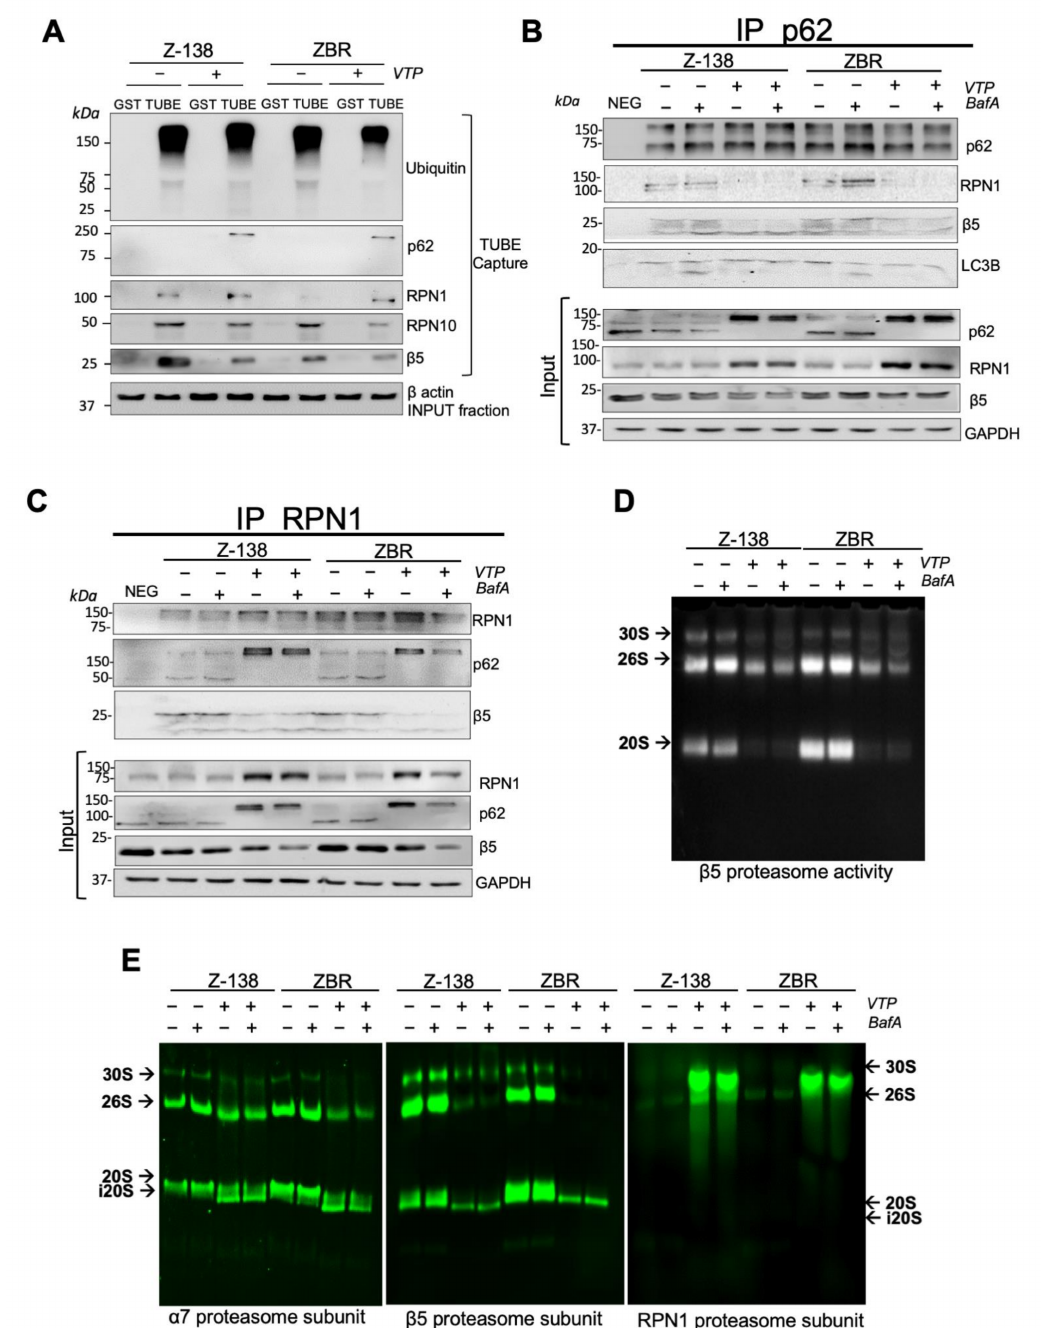
Figure 4. Role of p62 in proteophagosome assembly. ( A ) Ubiquitylated proteins were captured using TUBEs from Z-138 and ZBR treated or not treated with 10 µ M VTP for 4 h. GST was used as a control. Indicated fractions were analyzed by WB with the indicated Abs. ( B , C ) Cell lysates from Z-138 and ZBR were immunoprecipitated (IP) with anti-p62 and anti-RPN1 Abs. Immunoprecipitated material and input fractions were resolved and subjected to WB with the indicated Abs. ( D ) Cell extracts from Z-138 and ZBR treated or not treated with BafA, VTP or combined treatment were run into non-denaturing native gels. In gel proteasome activity assay was measured using fluorogenic peptides. ( E ) Native complexes separated as in ( D ) were transferred onto PVDF membranes and blotted with the indicated Abs ( n ≥